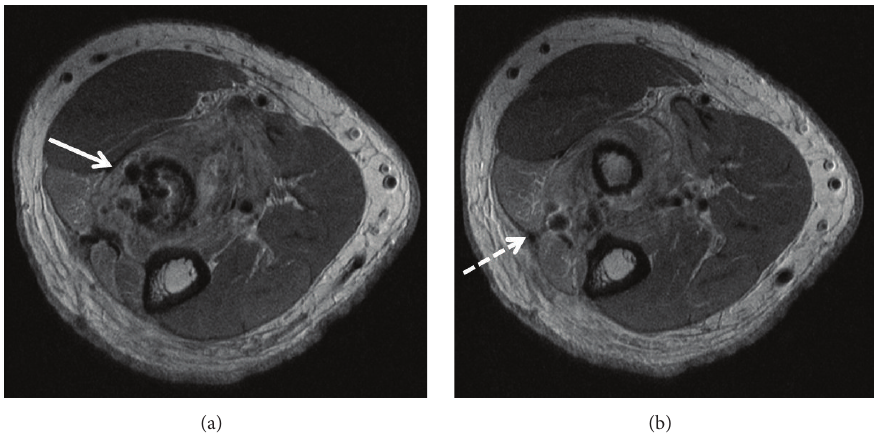
Figure 3: Two sequential axial proton density images ((a), (b)) in patient 3. Susceptibility artifact is noted in the expected location of the PIN along the posterolateral margin of the proximal radius (solid arrow, (a)). Note the scarring posteriorly indicating a two-incision approach (dashed arrow,